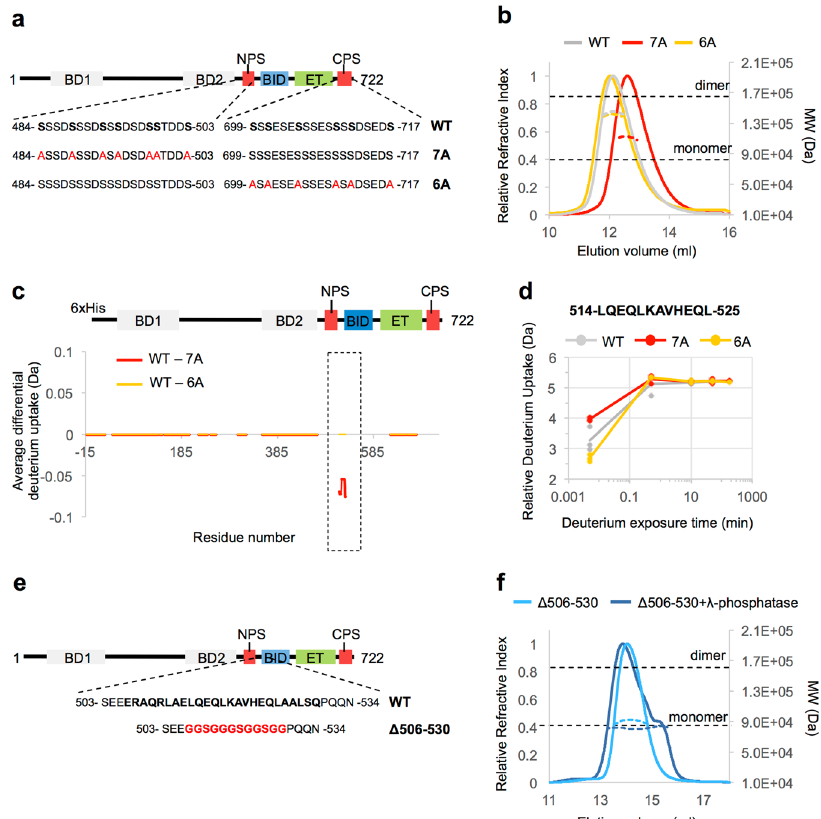
Fig. 4 Biophysical analysis of the regions and the phosphorylation sites required for BRD4 dimerization. a Schematic overview of the BRD4 1 – 722 phospho-de fi cient mutants 7A and 6A. In the wild-type (WT) sequence of NPS and CPS, the CK2 consensus sites are highlighted in bold. In the 7A and 6A mutant sequences, the serine residues mutated to alanine are highlighted in red. b SEC-MALS elution pro fi les for the BRD4 1 – 722 constructs, produced in E. coli and phosphorylated by CK2. The grey line indicates WT, red line indicates the 7A mutant, and yellow line the 6A mutant. The dotted lines at each peak, colored as above, indicate the experimentally calculated MW. The dotted horizontal black lines represents the theoretical MW of the monomer or dimer of BRD4 1 – 722 , calculated from the wild-type primary sequence. c Difference of deuterium uptake for each residue between the WT and the 7A (in red) or 6A (in yellow) mutants. All samples have been produced in bacteria and phosphorylated by CK2. A negative differential uptake indicates a lower deuterium uptake (more protected region) in the wild-type sample. Only peptides with changes above 0.5 Da and greater than 2.3x SD were taken into account. The increased exposure of motif B in the 7A mutant is highlighted with a rectangle with dotted line. Areas with no coverage are represented as gaps. For details on the calculation, see the Materials and Methods section. d Example of the relative deuterium uptake of a peptide within motif B. The uptake is substantially reduced in the shortest exposure time (3 sec on ice) in the phosphorylated BRD4 1 – 722 7A mutant compared to the phosphorylated wild type. The relative deuterium uptake (Da) over deuterium exposure time is reported for each n = 3 independent experiments. Grey circles and line indicates WT, red circle and line 7A mutant, yellow circle and line 6A mutant. e Schematic representation of the BRD4 1 – 722 Δ 506-530 produced in insect cells. In the wild-type (WT) sequence, the region spanning residues 506 – 530 is in bold. In the Δ 506 – 530 mutant sequence, the 12-residue glycine-serine-rich fl exible linker used to replace the 506-530 aa sequence is highlighted in red. f SEC – MALS elution pro fi les of the BRD4 1 – 722 Δ 506 – 530 produced in insect cells and treated (blue line) or not treated (light blue line) with λ -phosphatase. The dotted line at each peak, colored as above, indicates the experimentally calculated MW. The dotted horizontal lines represent the theoretical MW of the monomer or dimer of BRD4 1-722 Δ 506 –